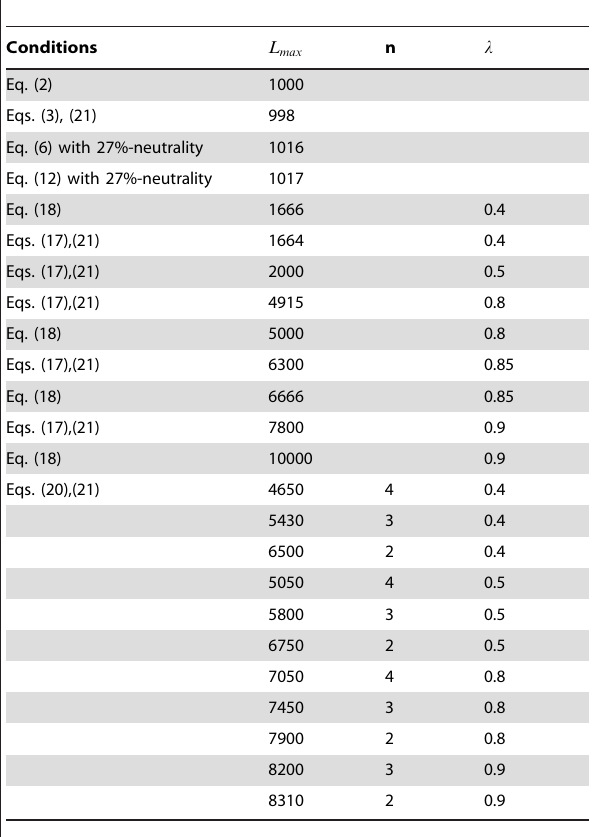
Table 3. The maximal allowed genome length L max obtained from different conditions (equations) for several values of the parameter of truncated selection n and the degree of lethal mutations l when ln A ~ 1 and 1 { q ~ 0 : 001